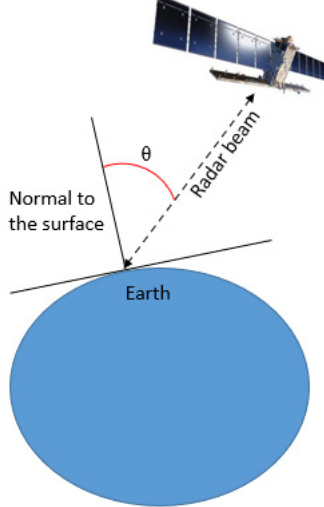
Figure 2. Local incidence angle ( θ ). The local incidence angle ( θ ) is defined as the angle between the incidence radar beam and a line that is normal to the surface, considering local relief, typically derived from a DEM.